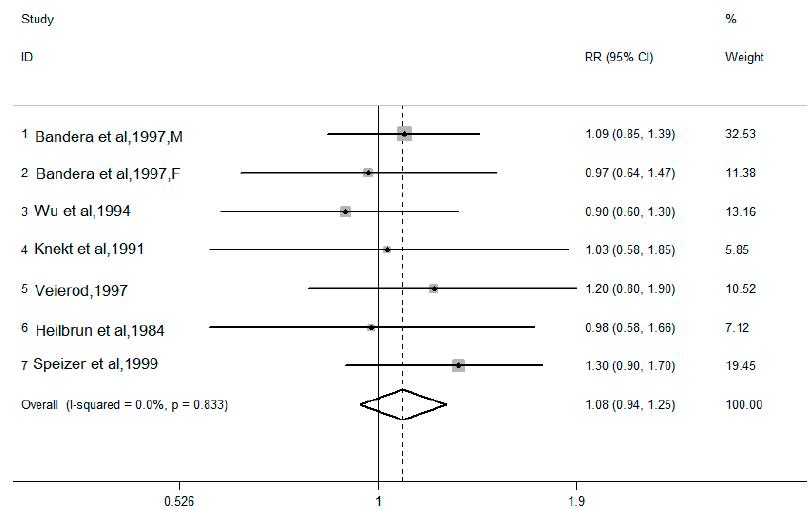
Figure 2. Forest plot of the highest compared with the lowest categories of intake of the dietary cholesterol and lung cancer risk in 10 case-control studies.